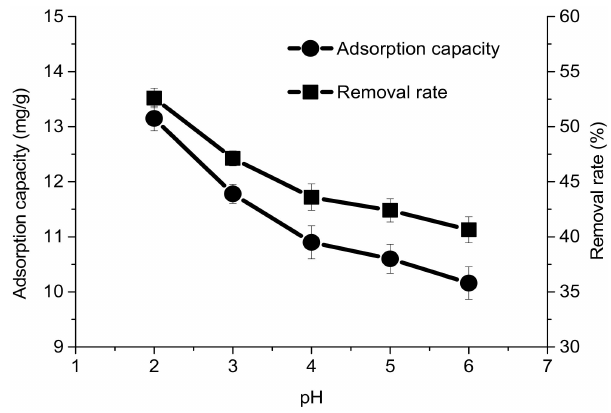
Figure 4. Effect of solution pH on the adsorption capacity and removal rate for Cr(VI).